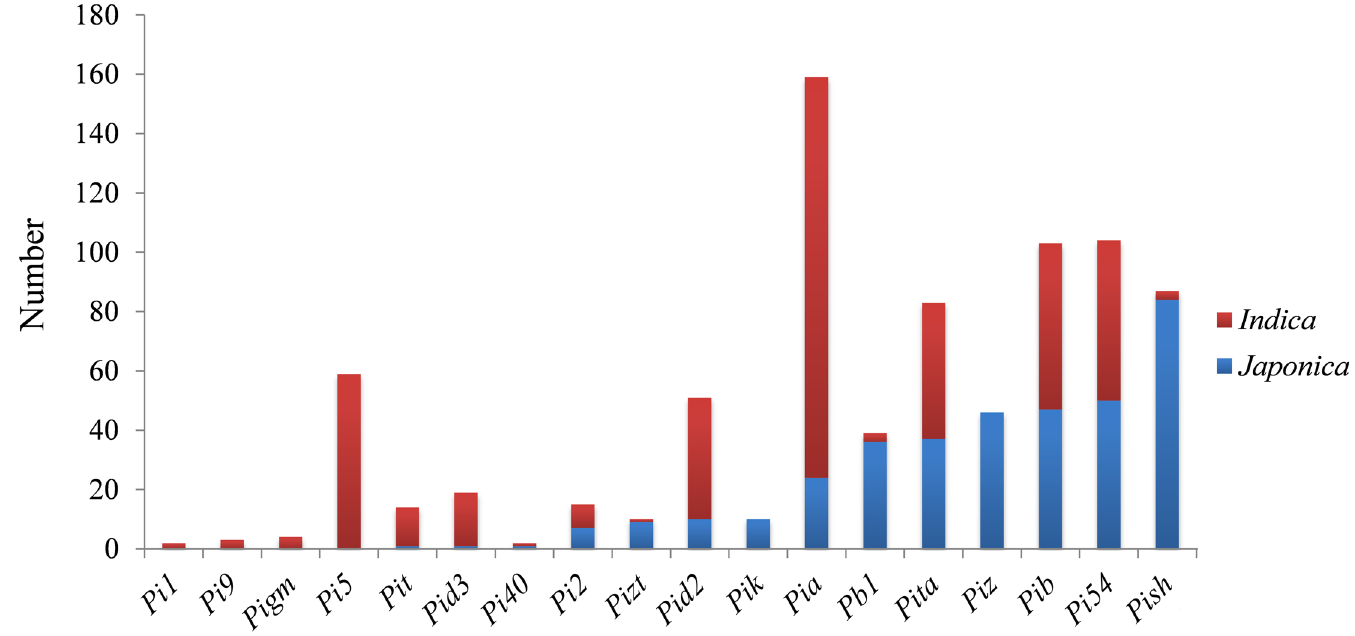
Fig 3. The distribution of R genes detected in 277 rice